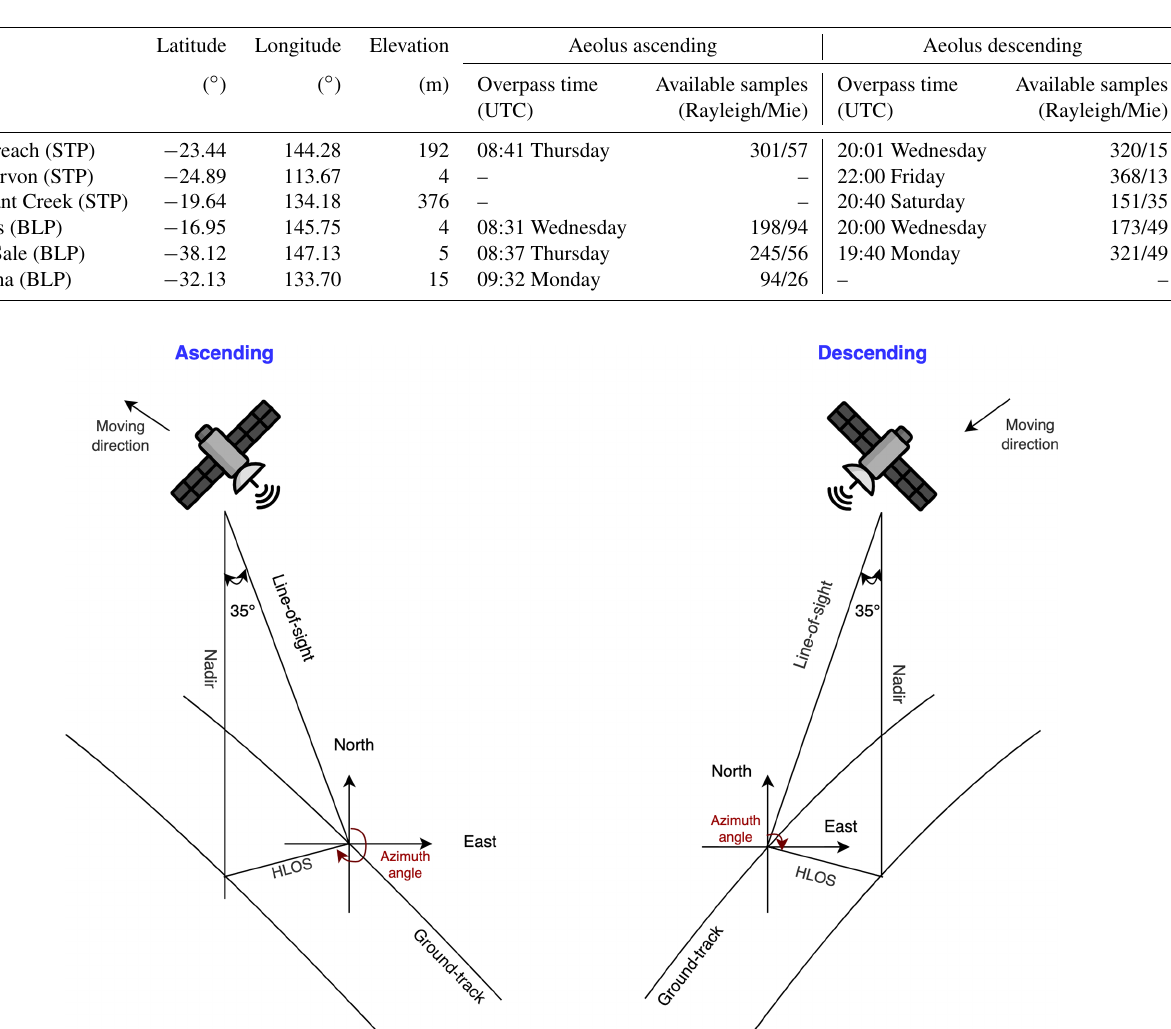
Table 1. Information of ground-based WPR sites and Aeolus measurements.